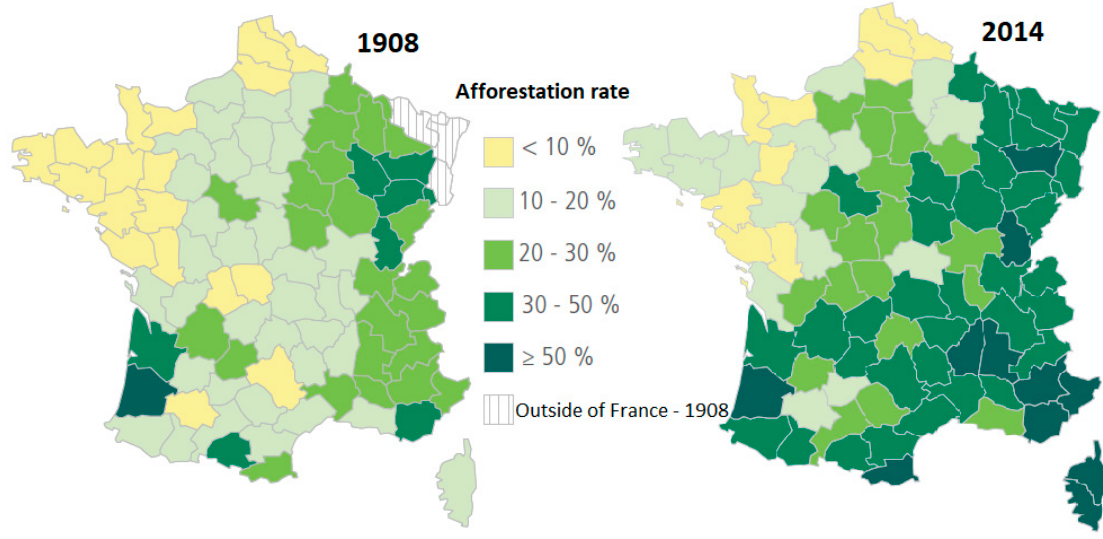
Figure 1. Afforestation rate of French territories in 1908 (left) and in 2014 (right), (IGN, 2018, modified).